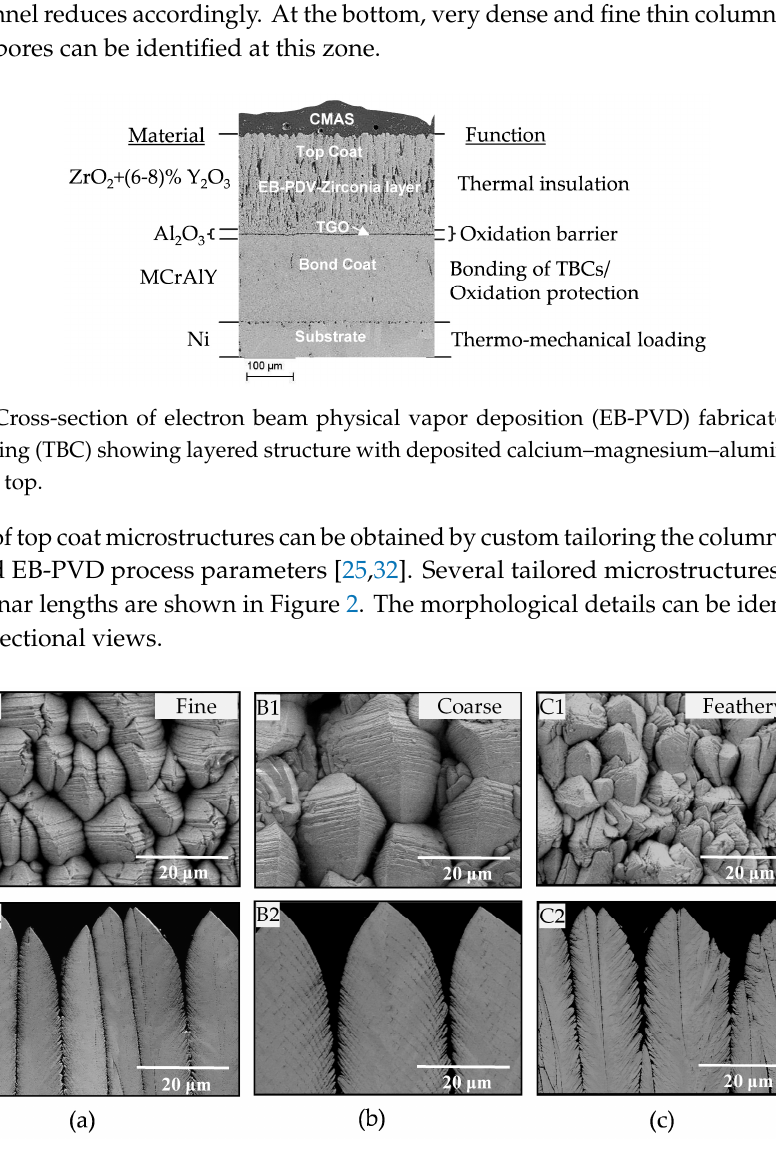
Figure 2. Tailored TBC microstructures fabricated by EB-PVD. Top view (upper A1, B1 and C1) and cross-sectional views (bottom A2, B2 and C2) are shown for: ( a ) Fine columnar microstructure; ( b ) coarse columnar microstructure; and ( c ) columnar microstructure with feathery arms (high porosity). Reprinted with permission from [25]; Copyright 2006 Elsevier.